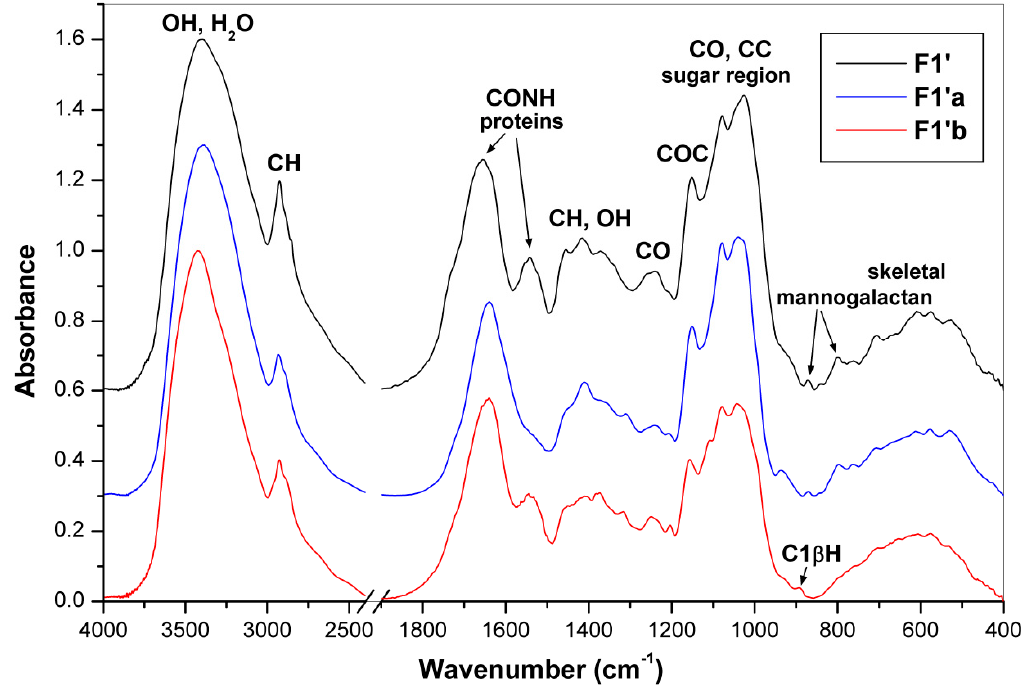
(cid:48) , F1 (cid:48) a and F1 (cid:48) b